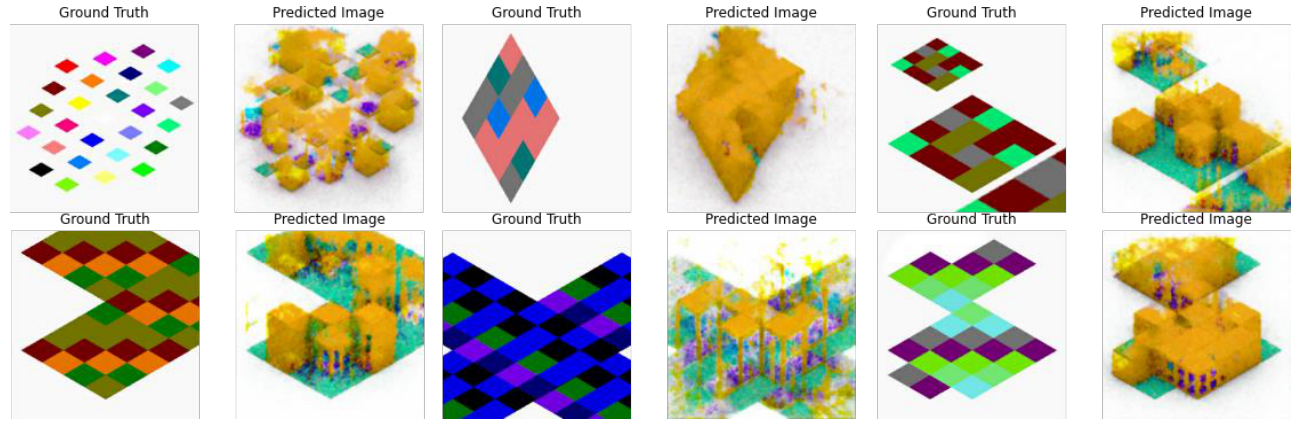
Figure 10. Captures from test D02.